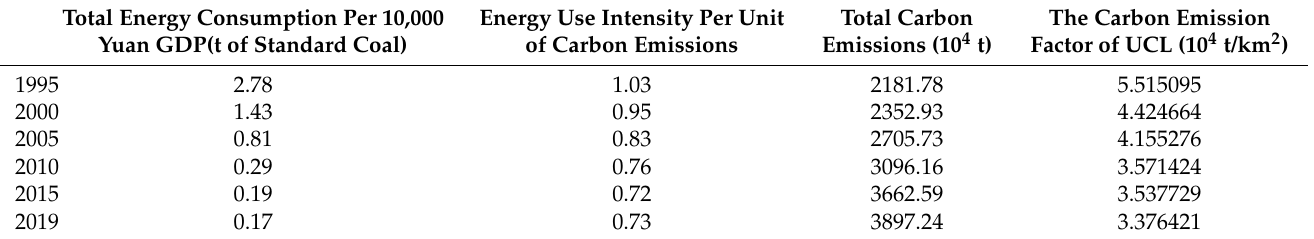
Table 4. Wuhan Carbon Emissions-Related Indices, 1995–2019.